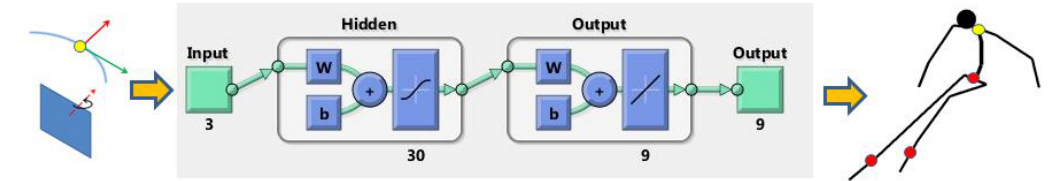
Figure 6. Framework for the estimation of skier’s pose using artificial neural